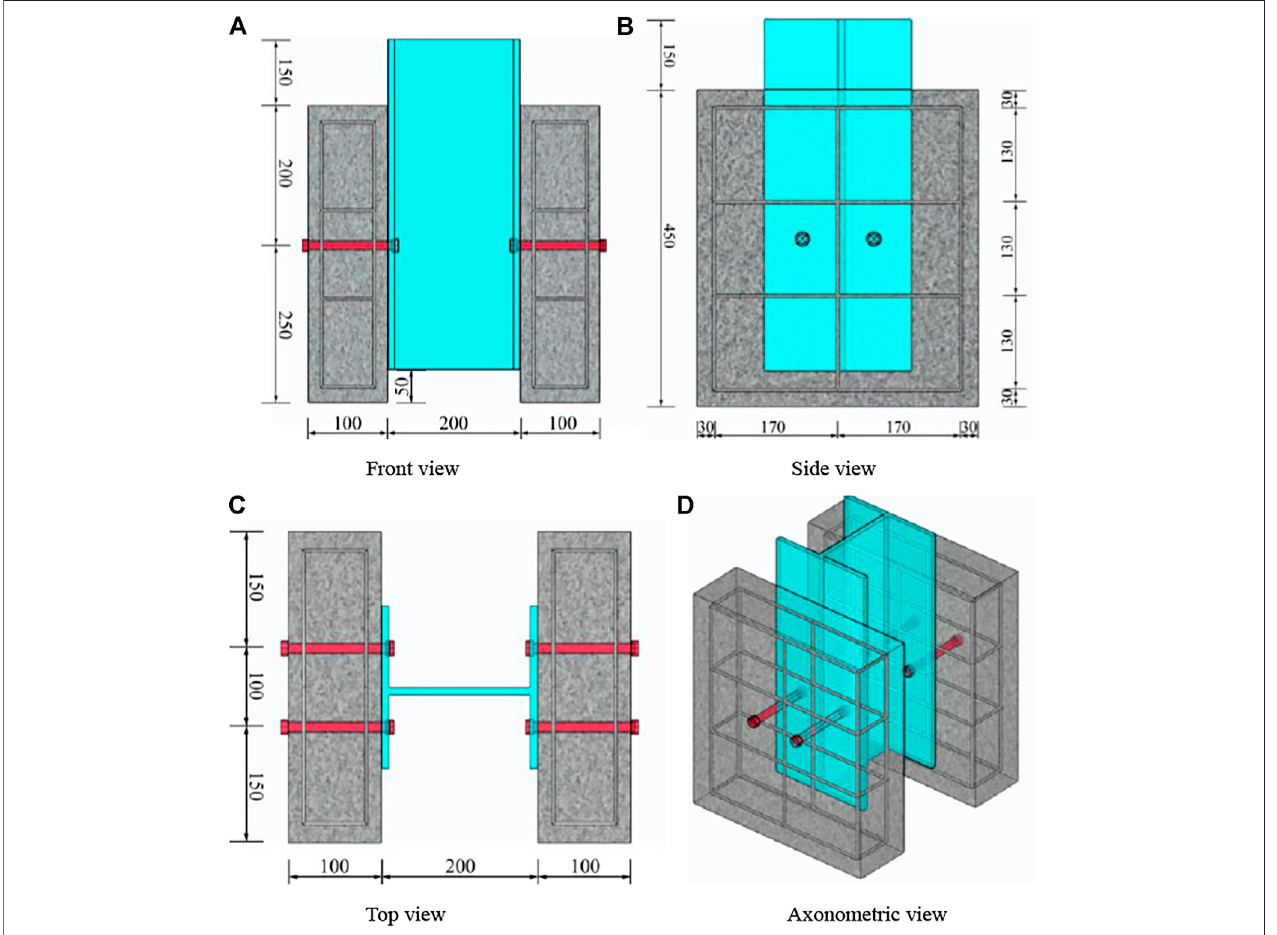
FIGURE 5 | Con fi gurations of test